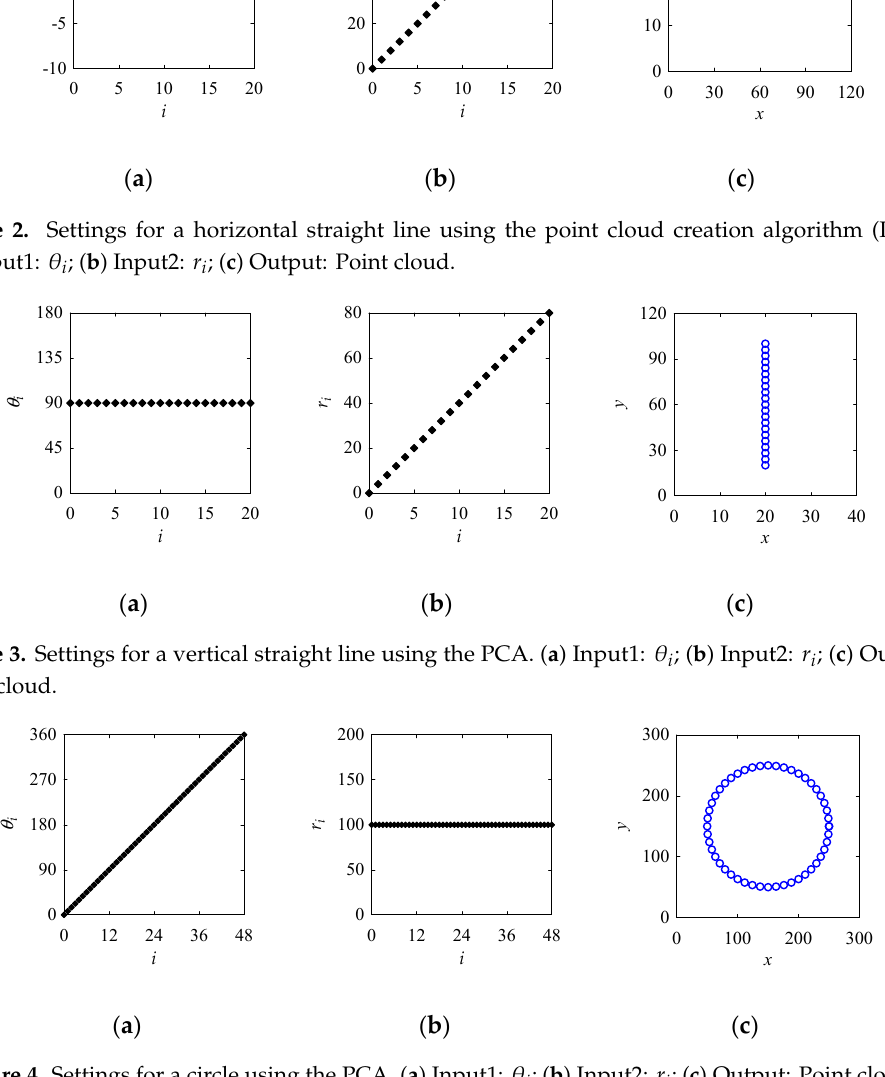
Figure 4. Settings for a circle using the PCA. ( a ) Input1: θ i ; ( b ) Input2: r i ; ( c ) Output: Point cloud.